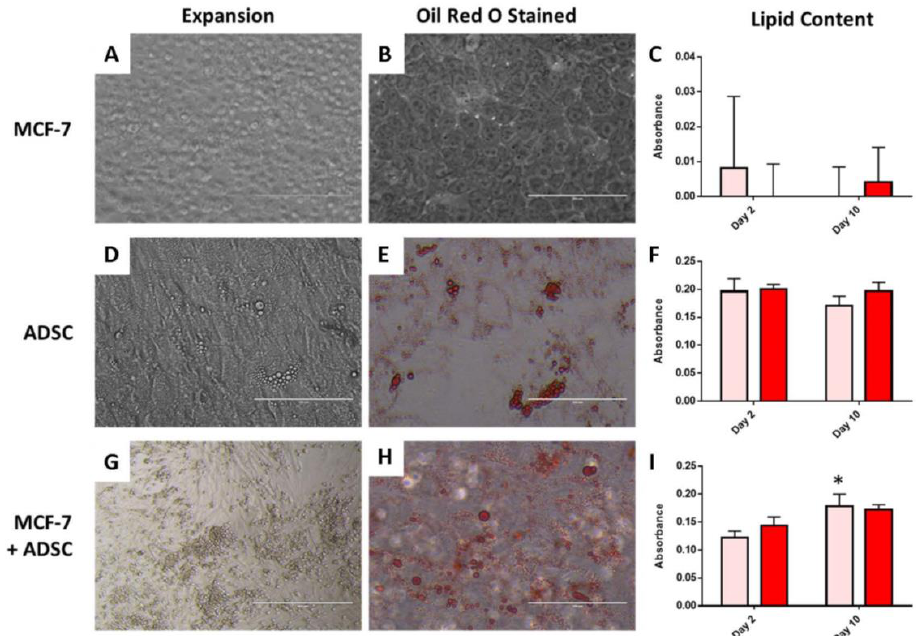
Figure 5. Expansion of ( A ) MCF-7 cells, ( D ) ADSCs and ( G ) MCF-7 and ADSCs co-cultured after